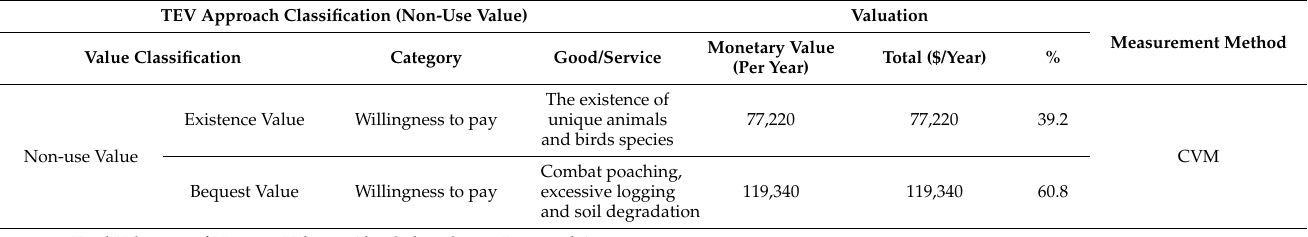
Table 2. Monetary values of ecosystem non-use value in Abu Qubies.